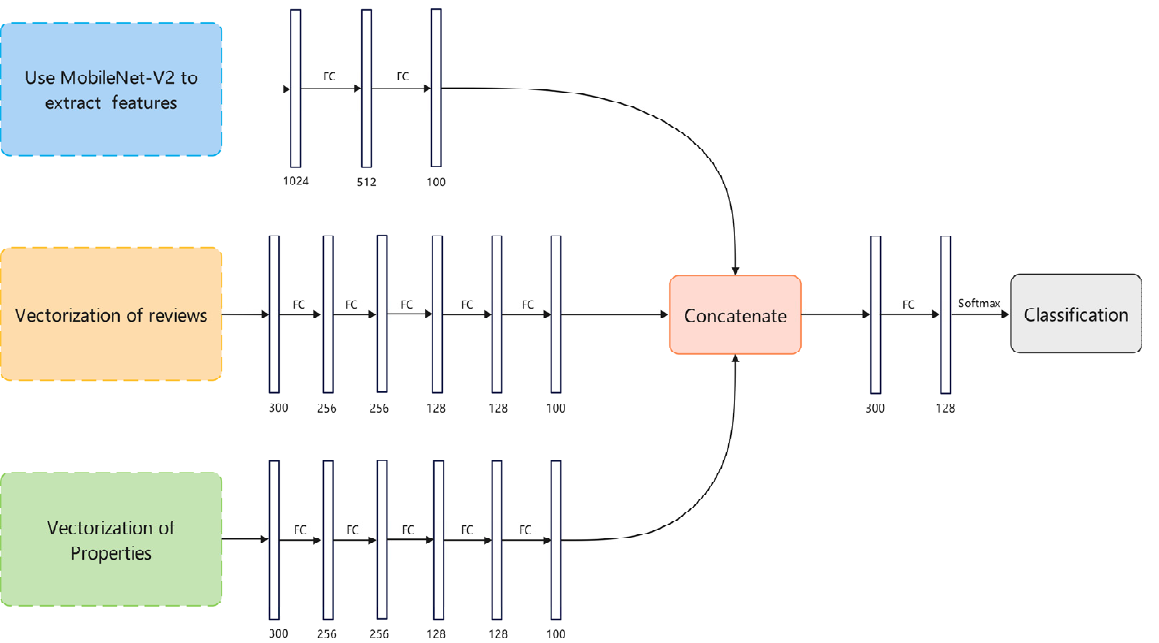
Figure 4. Detailed network architecture of the experiments. FC indicates the fully connected layer.